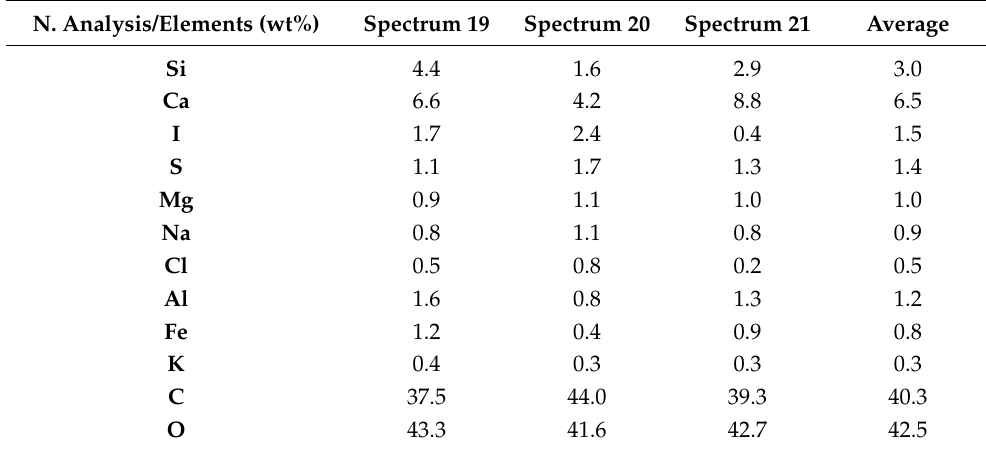
Table 2. Elemental analyses of Posidonia oceanica balls.